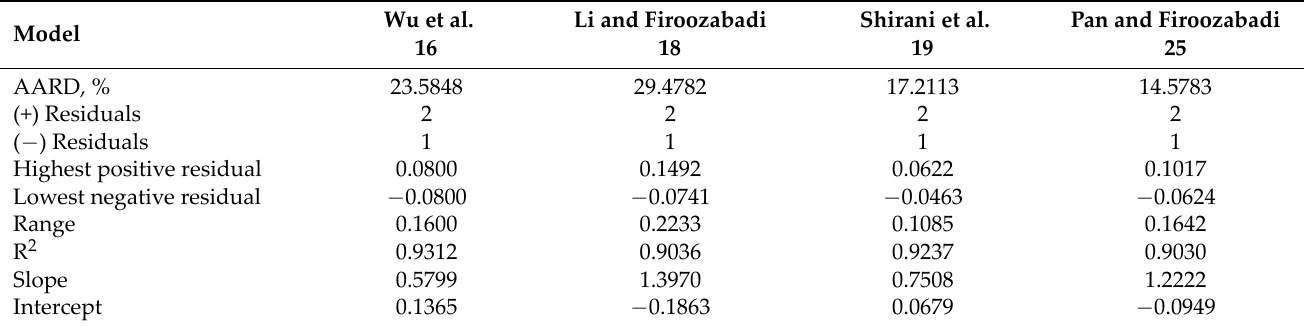
Table 7. Statistical analysis for models to calculate asphaltene precipitation by effects of CO 2 injec‑ tion.